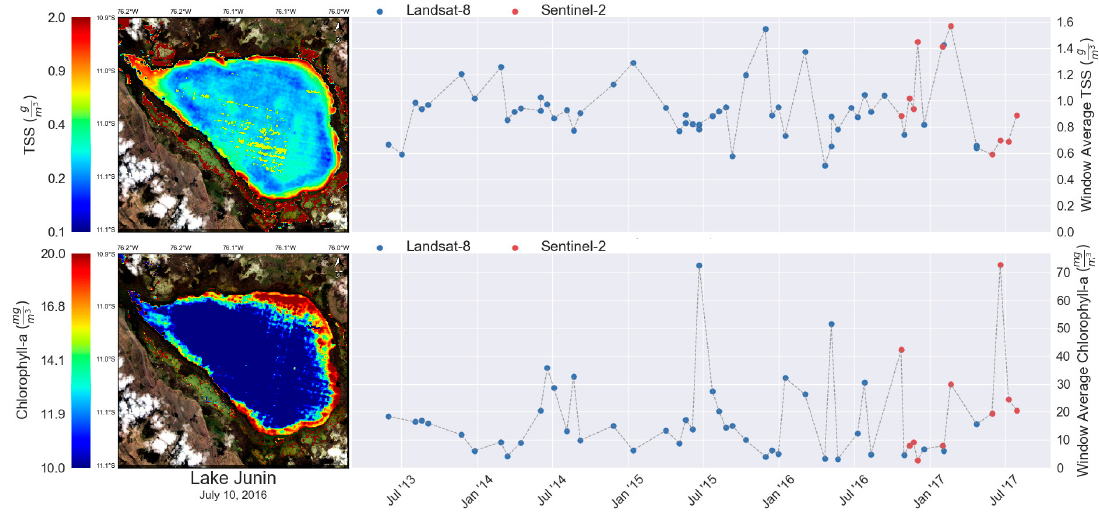
Figure 9. Time-series of lake-wide average TSS (g/m 3 ) and Chl (mg/m 3 ) in Lake Junin shown for the 2013–2017 period. Anomalies in Chl products can be identified in July 2015 and 2017, while lake-wide TSS products vary differently.